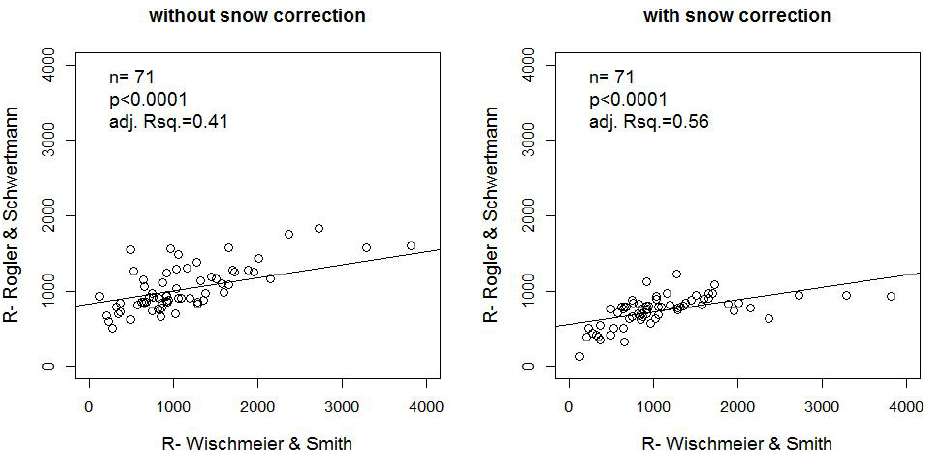
Fig. 5. Comparison or R -factor calculated from 10 min data versus R -factor based on average annual rainfall using the (left) approximation equation of Rogler and Schwertmann (1981) and (right) the adapted one by Friedli et al.